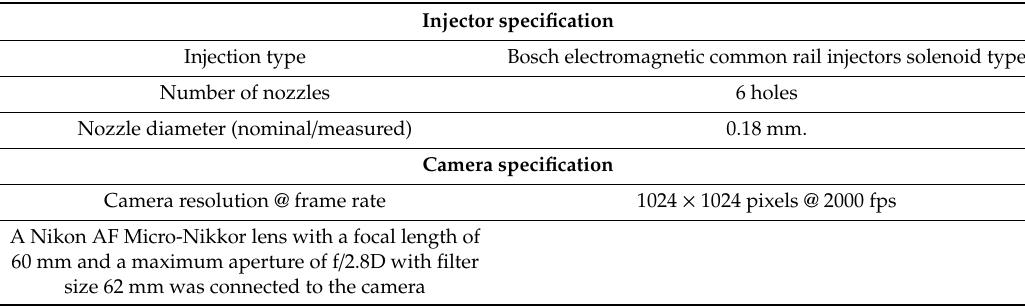
Figure 2. Schematic of spray setup system. Table 2. Specification of visualization system [4,20].